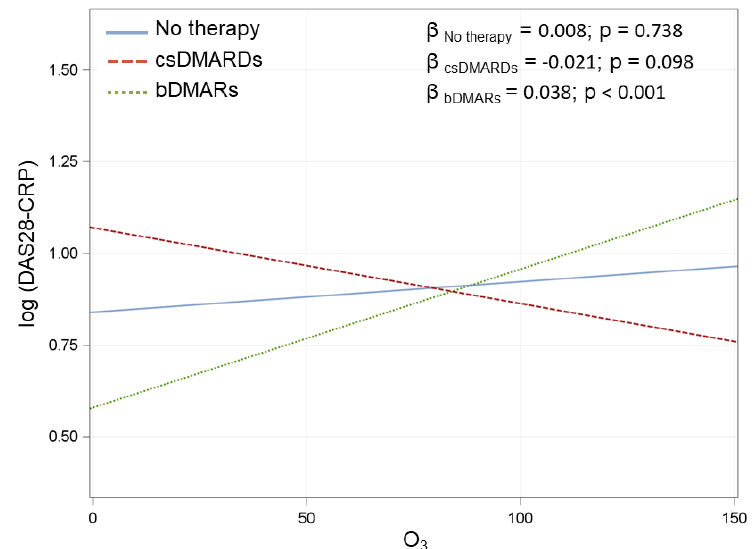
Figure A2. Association between O 3 at day-1 and DAS28-CRP in the three treatment groups. β coef- ficients are reported for 10 µg/m 3 increments in O 3 . IC–Interval Confidence. Multivariate model adjusted for radiological damage, smoke, seropositivity, treatment (3 categories), corticosteroids, age at visit, disease duration, and interaction between O 3 and treatment.